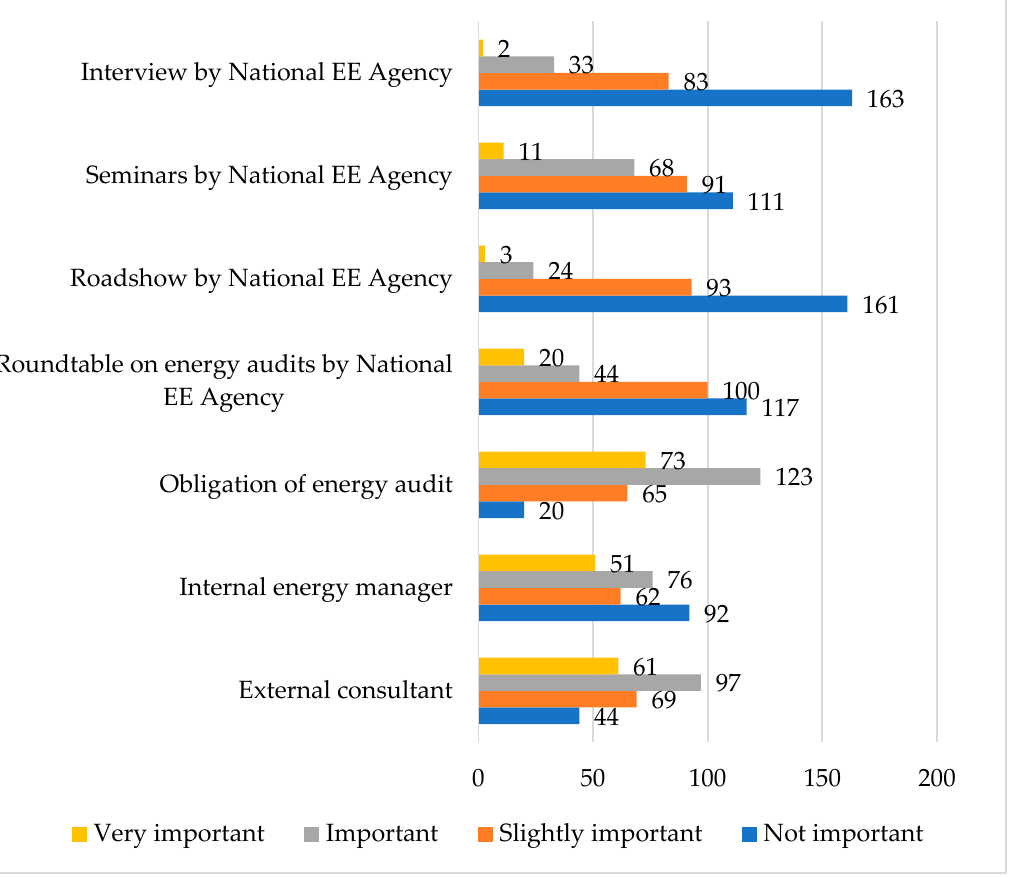
Figure 3. Importance of factors in contributing to the decision to implement energy efficiency measures.